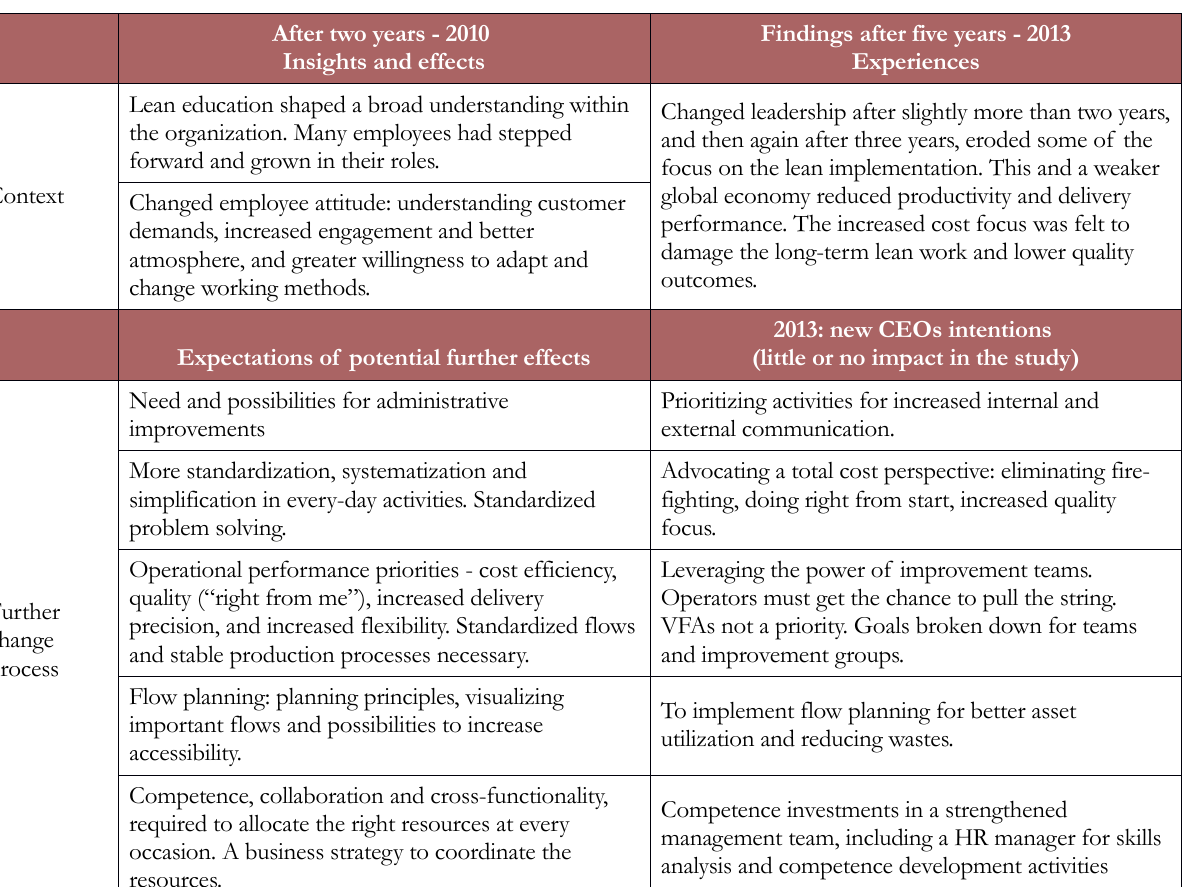
Table 1. Comparison of the change process after two and five